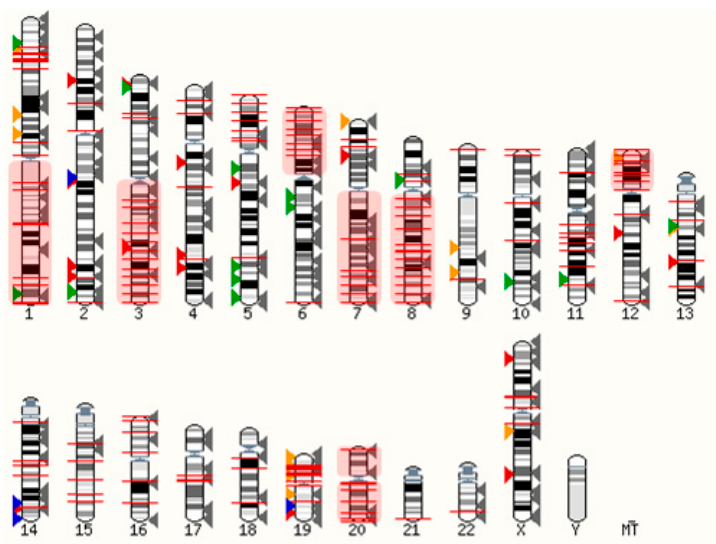
Figure 3. Distribution of GPCRs and copy number alterations (CNA on genome). All GPCRs (except olfactory receptors) are indicated with arrowheads. Overexpressed receptors are shown in color, according to Table 3. Red: Peptide and protein activated receptors; Orange: Lipid receptors; Green: Adrenergic receptors; Blue: Ionic receptors; Grey: Not frequently overexpressed in ovarian cancer (310 receptors). The red lines indicate 2902 CNAs with frequencies ranging from 5%–34% (from TCGA, Pan Cancer Atlas, 572 ovarian serous cystadenocarcinoma samples; accessed via cBioportal [199,200] on 3 March 2022). Frequently amplified chromosome arms 1q, 3q, 6p, 7q, 8q, 12p, 20p, 20q are shown in red shaded boxes. The human karyotype figure was generated using Ensembl 2021 [201].